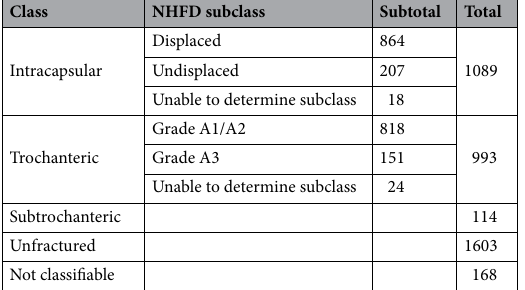
Table 2. Ground-truth classification according to musculoskeletal experts for Dataset